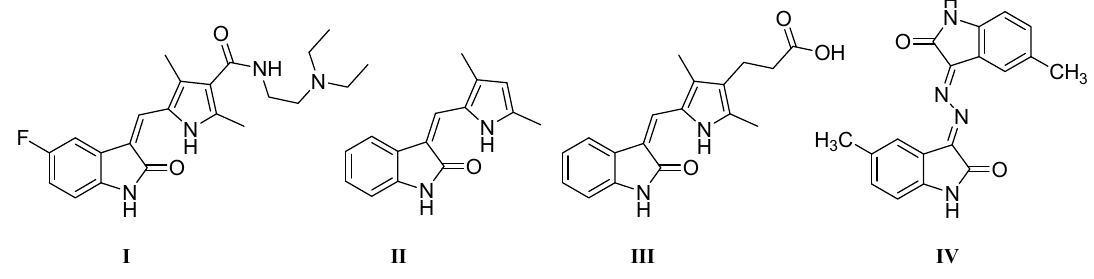
Figure 1. Chemical structures of some anticancer agents bearing an isatin nucleus.